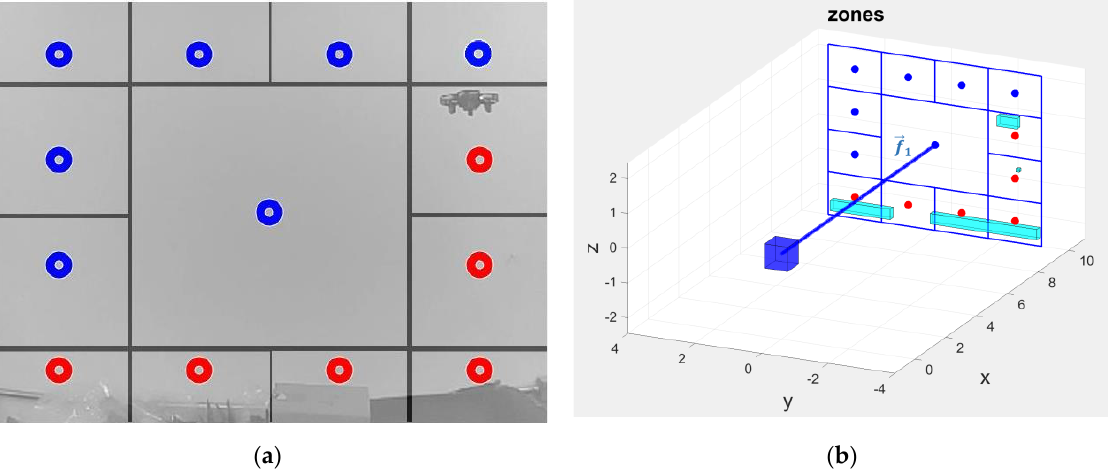
( d ) Figure 7. Experimental numerical results obtained when the vector 𝒇⃗ 𝟕 is used as a reference: ( a ) motion control; ( b ) attitude control; ( c ) control inputs; ( d ) 3D simulation. 3.2. Experiment 2 For this case, the video frame acquired from the UAV camera is shown in Figure 8a. As observed, there are six regions (𝑅 2 , 𝑅 9−13 ) with detected objects whose centers are marked with red dots, and the free regions found are 𝑅 1 , 𝑅 3−8 (center marked with a blue dot). Using the UAV position coordinates and the central coordinates of the collision − free